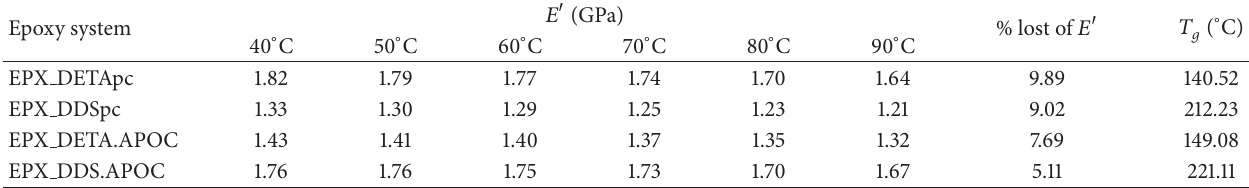
Table 3: Storage modulus ( 𝐸 󸀠 ) and 𝑇 𝑔 (tan 𝛿 peak) for different epoxy systems. Epoxy